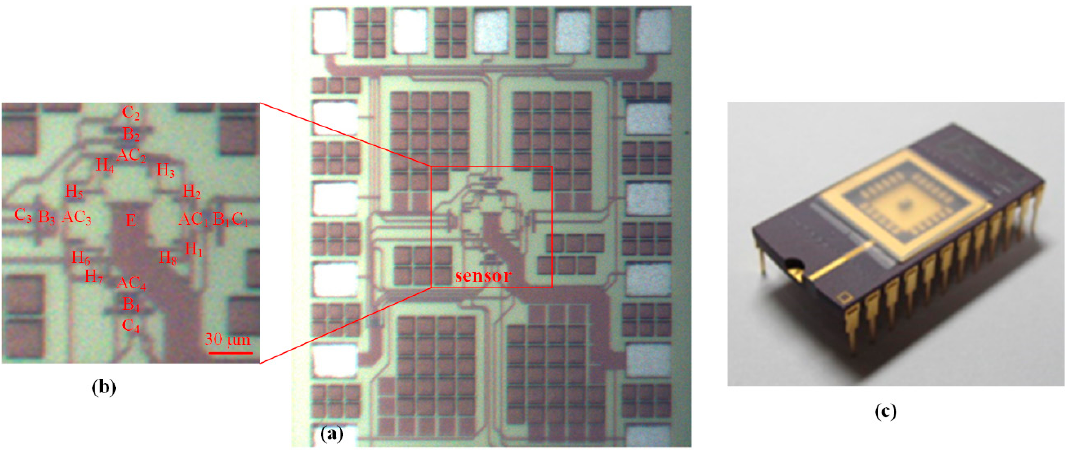
Figure 7. Picture of the MMF sensor chip.